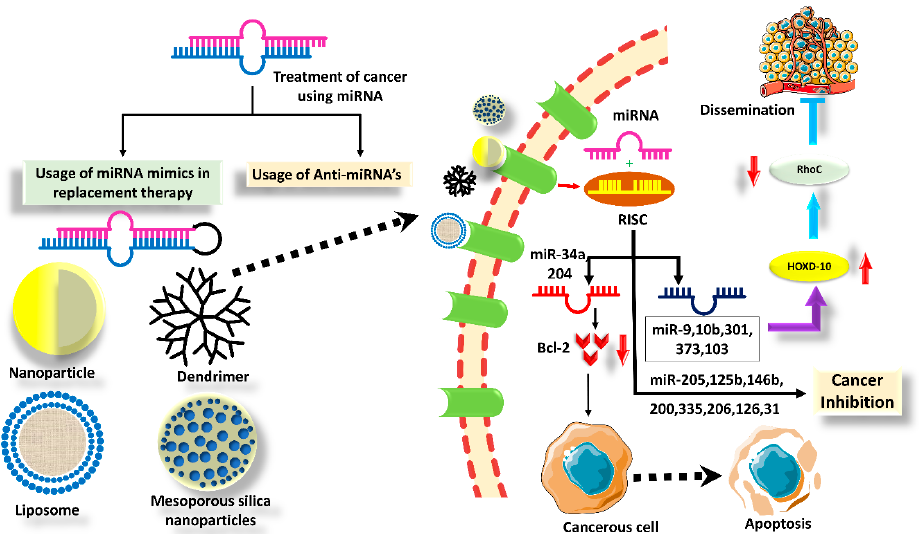
Figure 3. An overview of various delivery platforms through which miRNAs can be delivered to biological systems . Delivering tumor suppressor miRNA to primary tumor cells via nanoformula- tions. The optimum nanoformulation for TS miRNA should be well tolerated, safe, and capable of targeting tumors with few unwanted side effects. It should also be readily absorbed by cancer cells and deliver high concentrations of TS miRNA. This figure shows the delivery system for TS miRNAs to the cancerous cells and associated